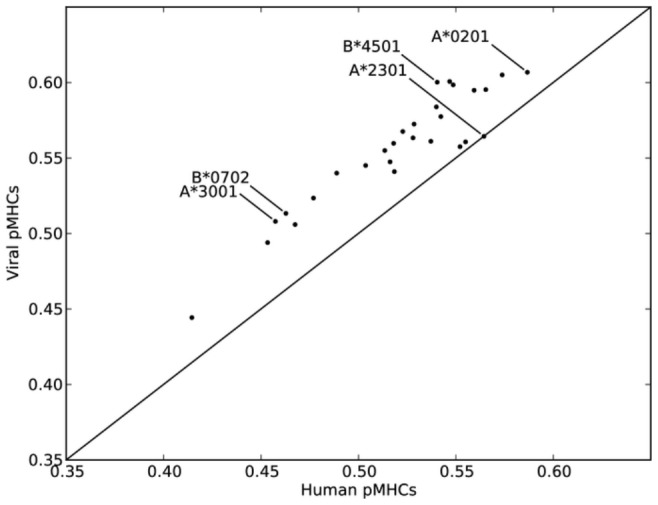
Viral pMHCs are better recognized by T-cells.For common HLA molecules (13 HLA-A and 15 HLA-B), viral and human ligands were predicted using MHC binding and precursor protein processing predictors (as in [40]). The fraction of viral pMHCs (y-axis) and human pMHCs (x-axis) with a positive score in our immunogenicity model is shown. The diagonal denotes the line y = x, HLA molecules with a larger fraction of positively scoring viral pMHCs fall above this line, which was the case for 27 of the 28 HLA molecules (sign-test: p<0.001). Three HLA molecules where the difference between the (predicted) viral and human ligands was largest (B*0702, A*3001, B*4501), and one HLA molecule where the difference between viral and human ligands was smallest (A*2301), and HLA-A*0201 are indicated in the figure.